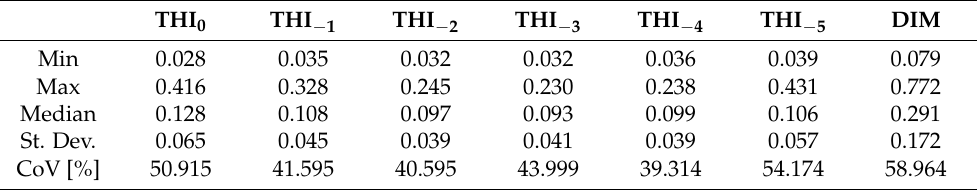
Figure 11. Boxplot diagram of the importance score of the different features for the whole dataset in scenario B. Table 2. Minimum value, maximum value, median value, standard deviation value, and coefficient of variation (CoV) value of the ISs obtained for the different independent variables calculated for the whole dataset in scenario